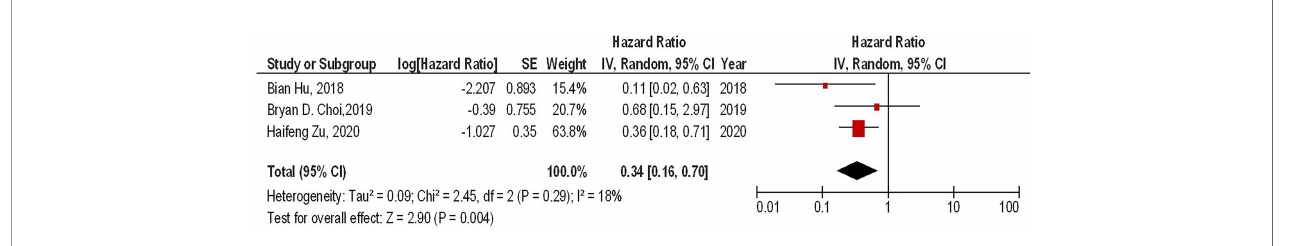
FIGURE 3 | The forest plot of studies evaluating the effect of PD-1 knockdown on the survival of animal models treated with CAR-T cells.